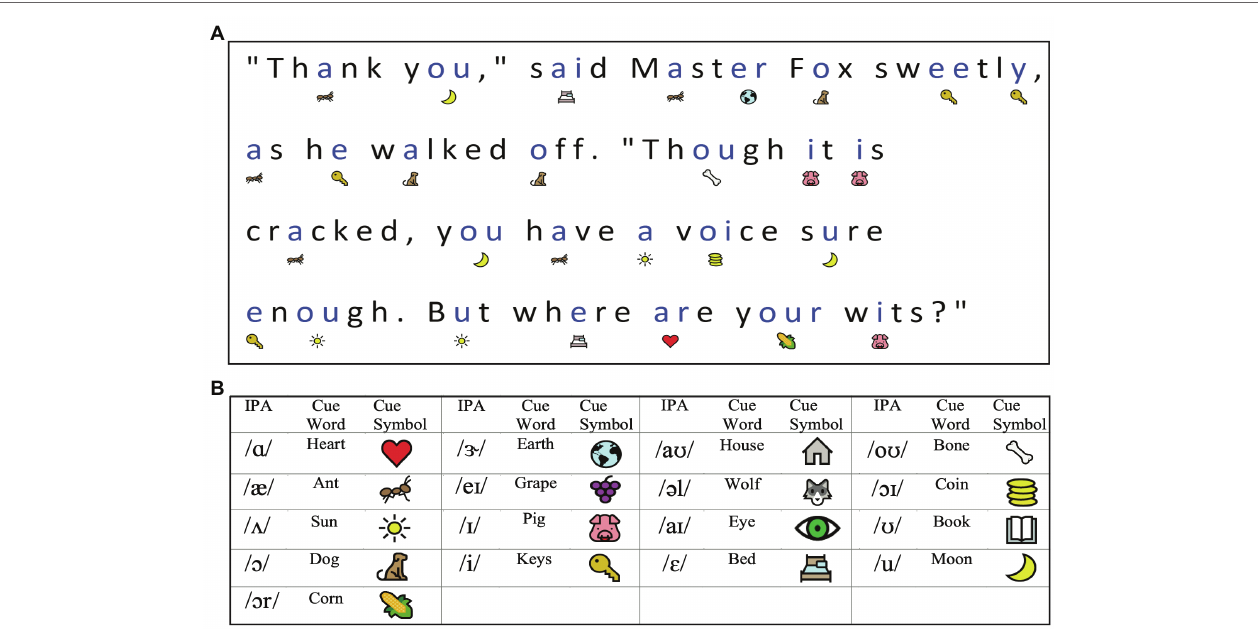
FIGURE 3 | Visualization of the Reading Study : Sound it Out provides visual cues under each word that prompts readers on the pronunciation of the vowels contained in the words. Panel (A) presents a sample of a fable passage with symbolic annotations. Panel (B) shows the legend of the image cues used. (Donnelly et al.,